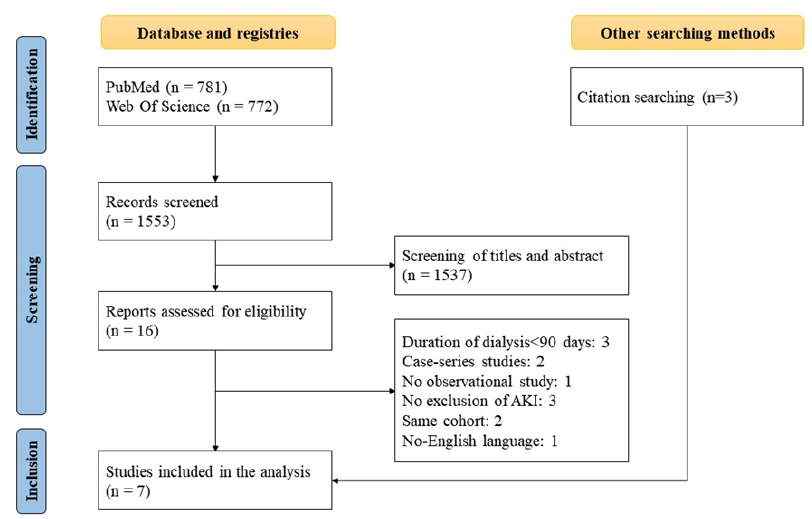
Figure 1. Algorithm of selection.